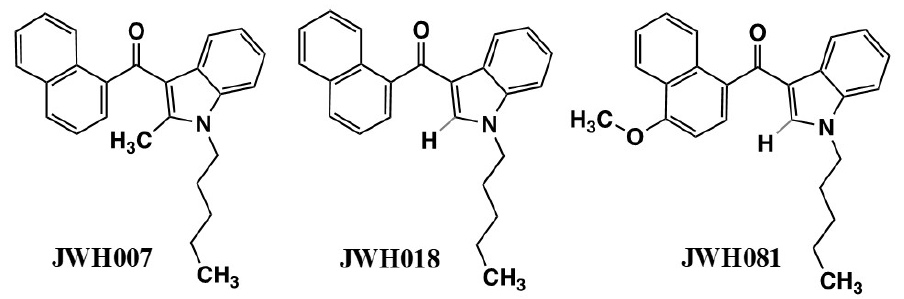
Figure 4. Alkyl indole compounds developed to test the Common Pharmacophore